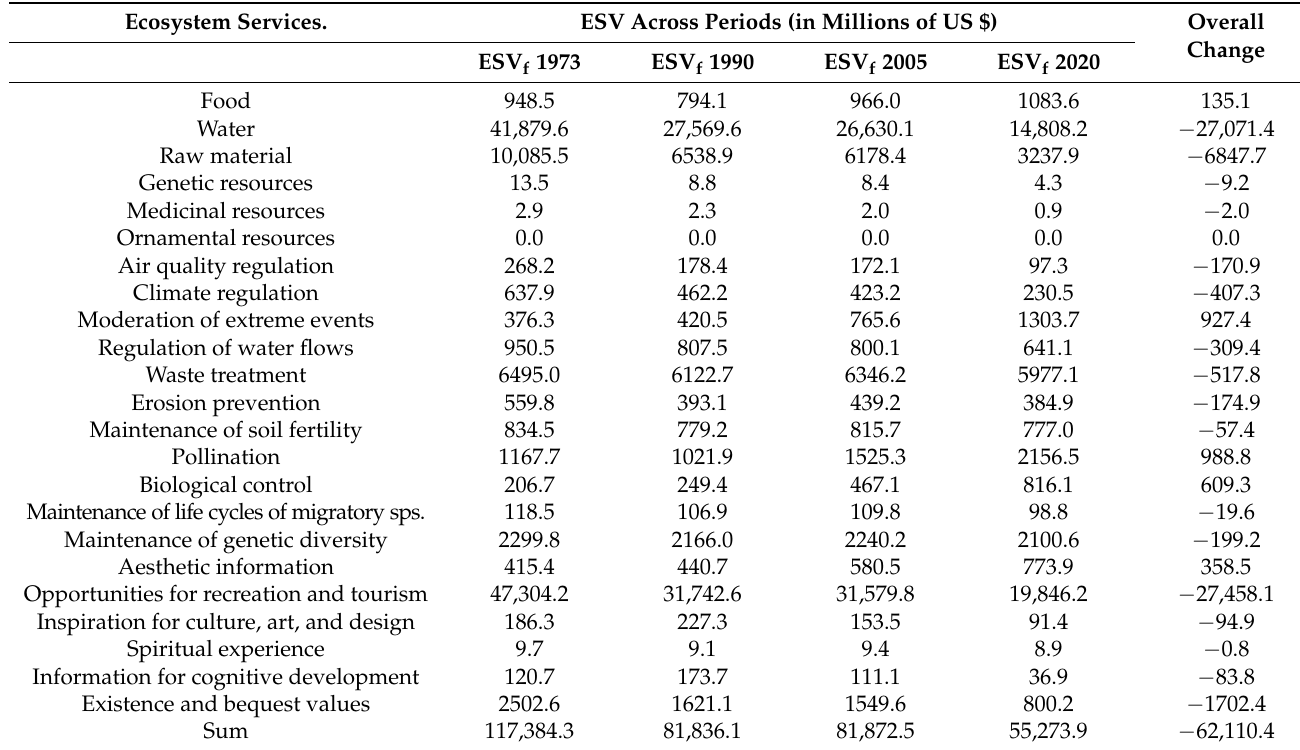
Table 9. Effects of land use and land cover changes on individual ecosystem services or functions in the basin over a period of 47 years. Note: ESV = ecosystem service value. Ecosystem Services.